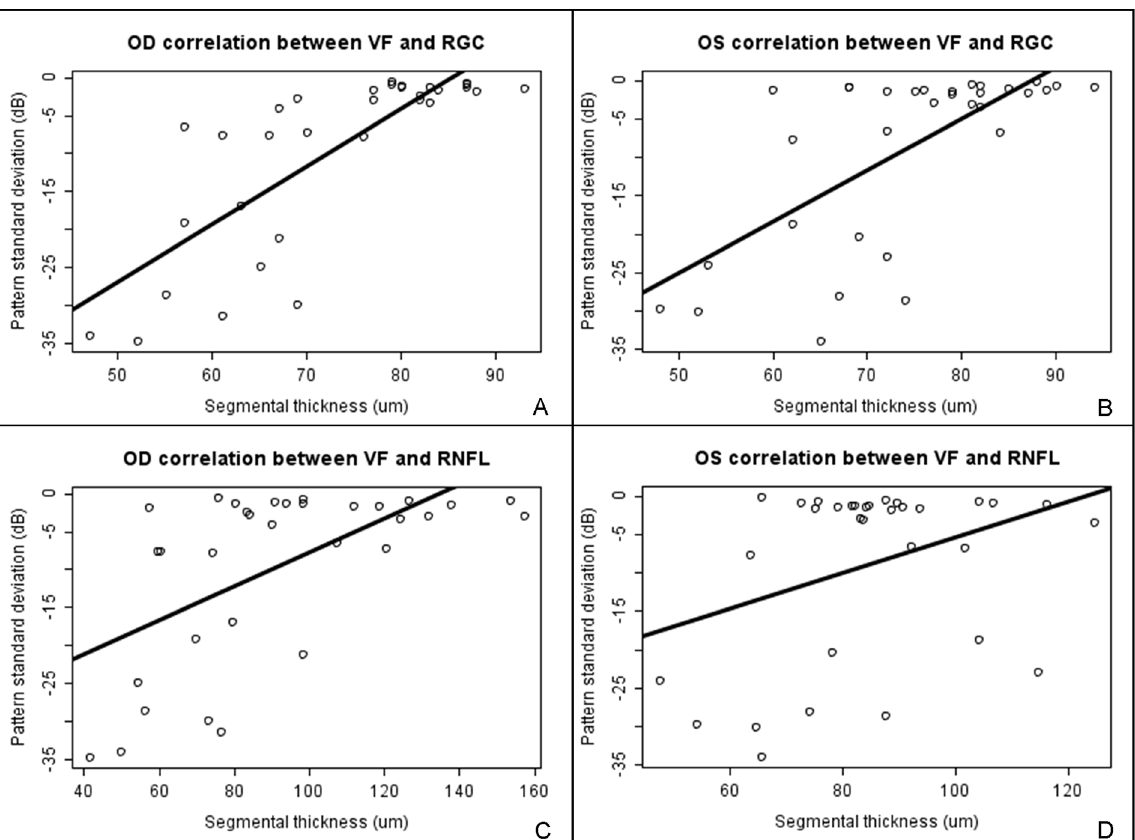
Figure 2. Scatterplot showing dispersion and linear regression of quadrant PD depression vs GCL thickness in the right (A) and left (B) eyes of all patients. PD depression vs RNFL thickness is shown for the right (C) and left (D) eyes.